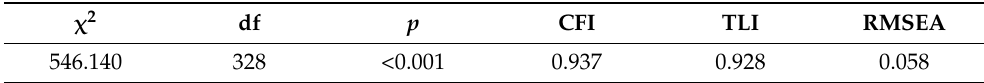
Table 7. Structural equation model’s fit analysis